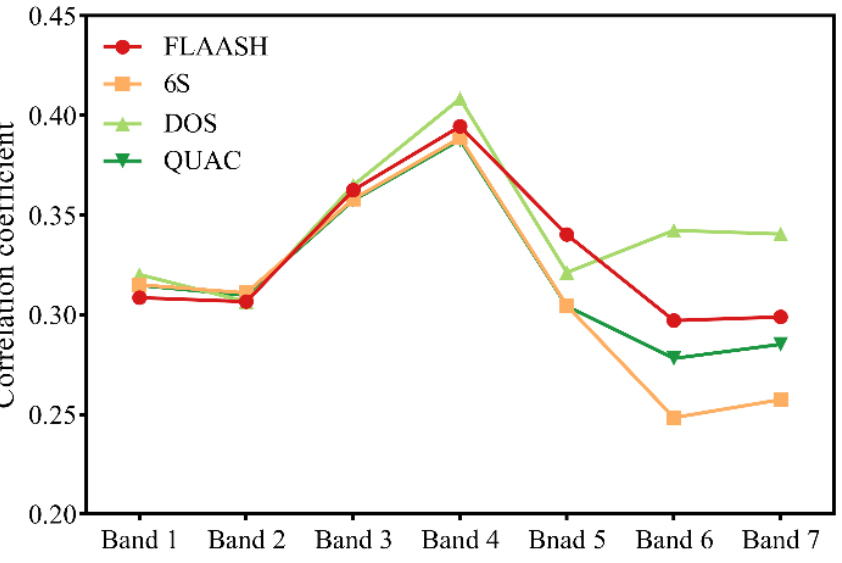
Figure 4. Correlation coefficients between remote sensing reflectance and TLI after different atmo- spheric correction modules.